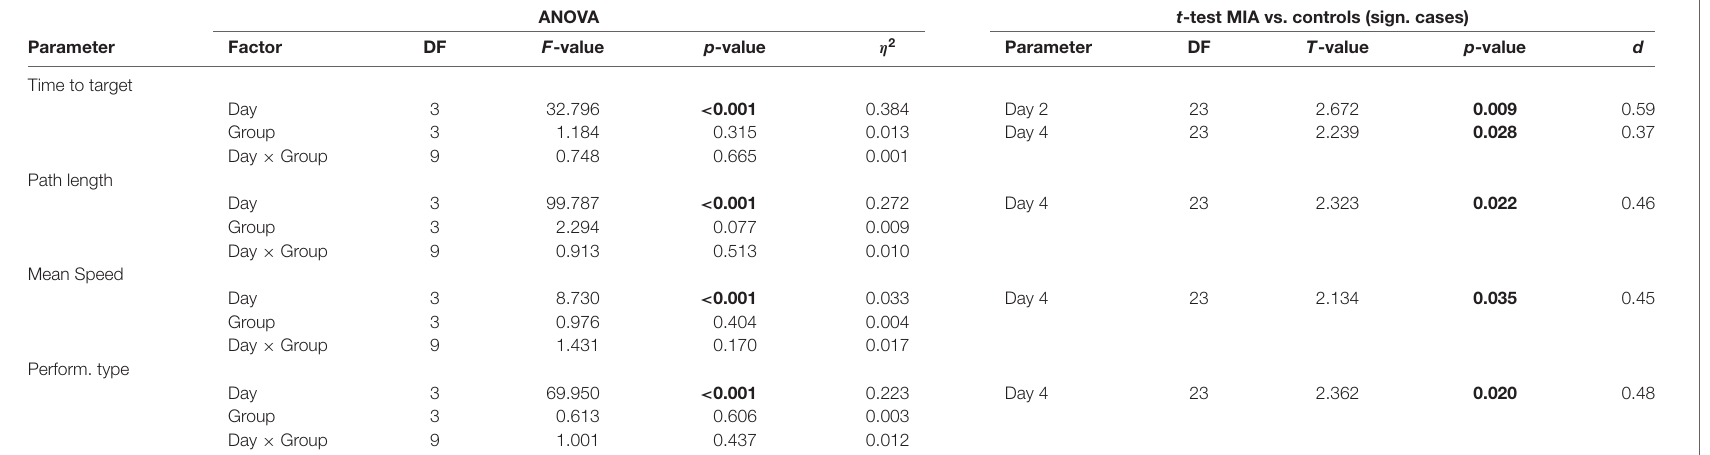
TABLE 4 | ANOVA and post hoc t -test results of the analysis of MWM data in case of iTBS applied to juvenile rats, using factors Group (MIA, controls) and Days (1–4). ANOVA t -test MIA vs. controls (sign.